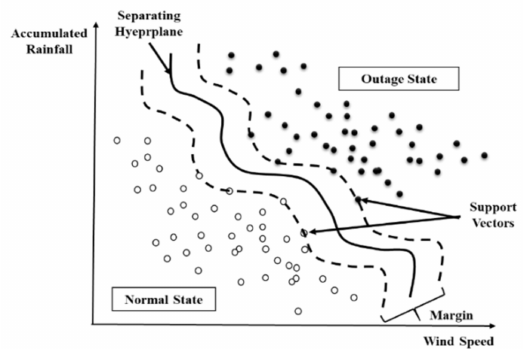
Figure 4. Support vector and margin in support vector manchine